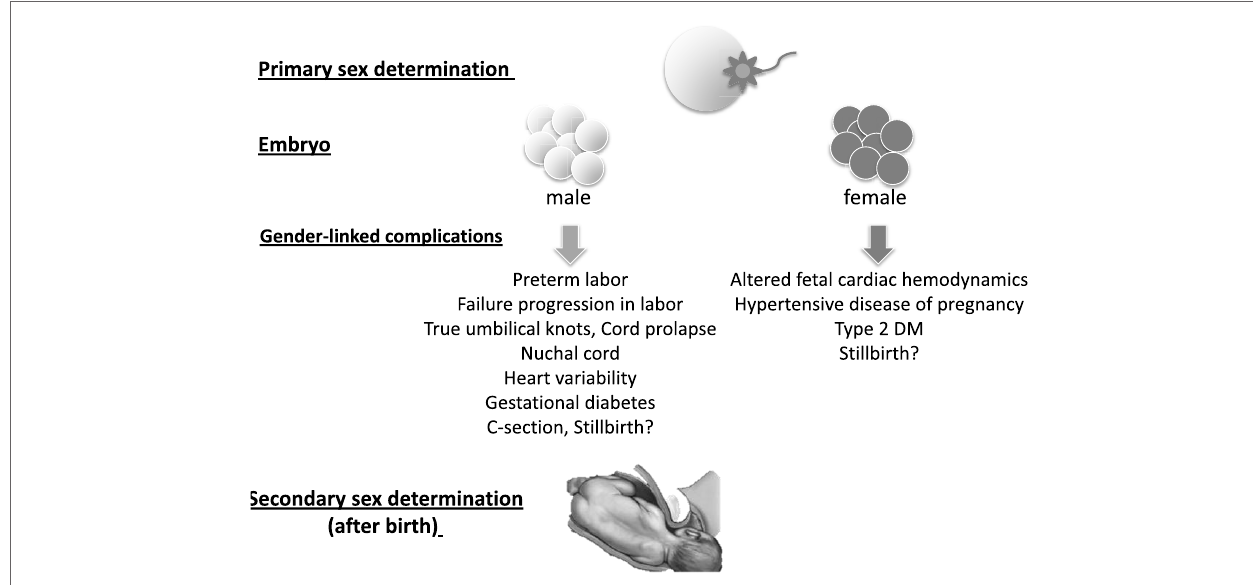
FiGURe 1 | Primary sex rate is determined at birth. However, along gestation different circumstances modify survival of fetuses from different gender and therefore secondary sex rate is that present at